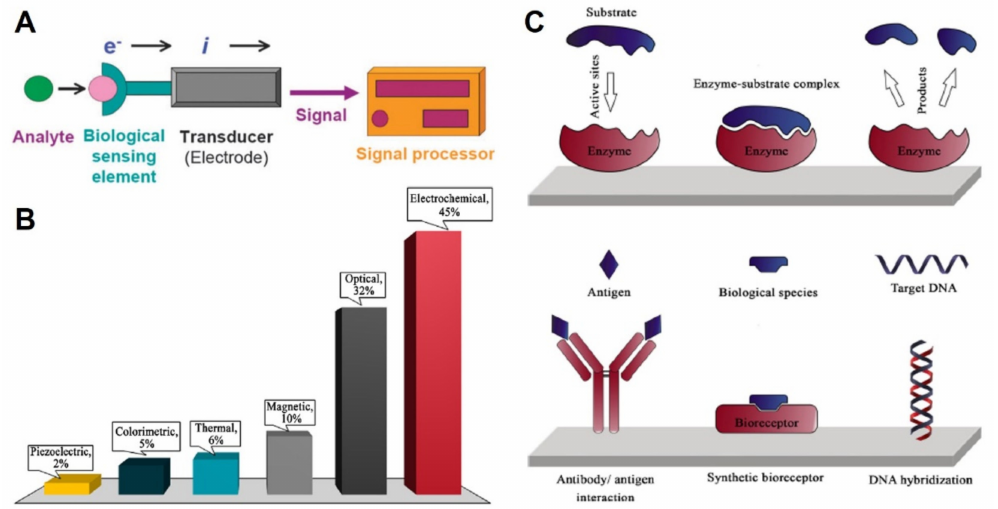
Figure 3. ( A ) A schematic representation of a biosensor with electrochemical transduction. Reproduced from [43] with permission from The Royal Society of Chemistry. ( B ) Distribution of di ff erent types of techniques for signal transduction using biosensors (data retrieved from the Scopus database from 2017 to August 2019). Reproduced from [25] with permission from Springer 2019. ( C ) Schematic illustration of enzymatic reaction on catalytic-based biosensors (top) and three di ff erent types of a ffi nity-based biosensors (bottom). Reproduced from [25] with permission from Springer